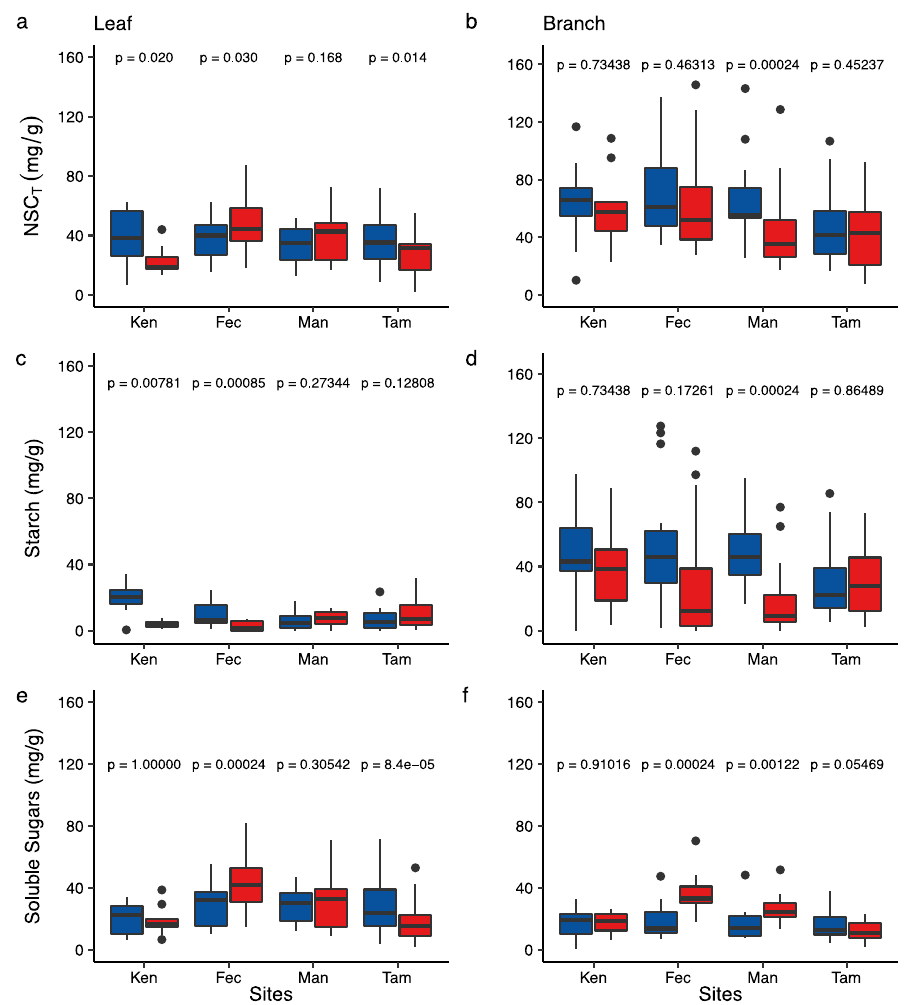
Fig. 3 Seasonal variation of total NSC (NSC T ), starch and soluble sugars (SS) across Amazon forests. Sites are ordered from left to right, from driest to wettest site. Panels a , c and e represent leaves and panels b , d and f represent branches. Red boxes denote the dry season and blue boxes denote the wet season. Each box encompasses the 25th to 75th percentiles; the median is indicated by the horizontal line with each box while external horizontal lines indicate the 10th and 90th percentiles; dots indicate outliers. Number of species sampled in each site are the same in the dry and wet season and are as follows: Ken = 9, Fec = 14, Man = 13, Tam = 21. To test for differences between season within site we used paired sample Wilcoxon